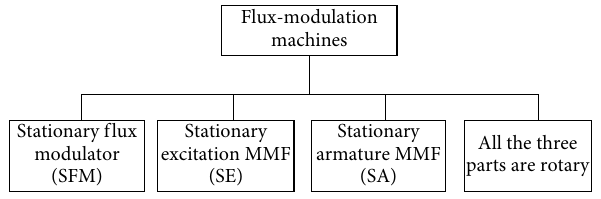
Fig. 15 Classification of FMPMM (reprinted with permission from Ref.